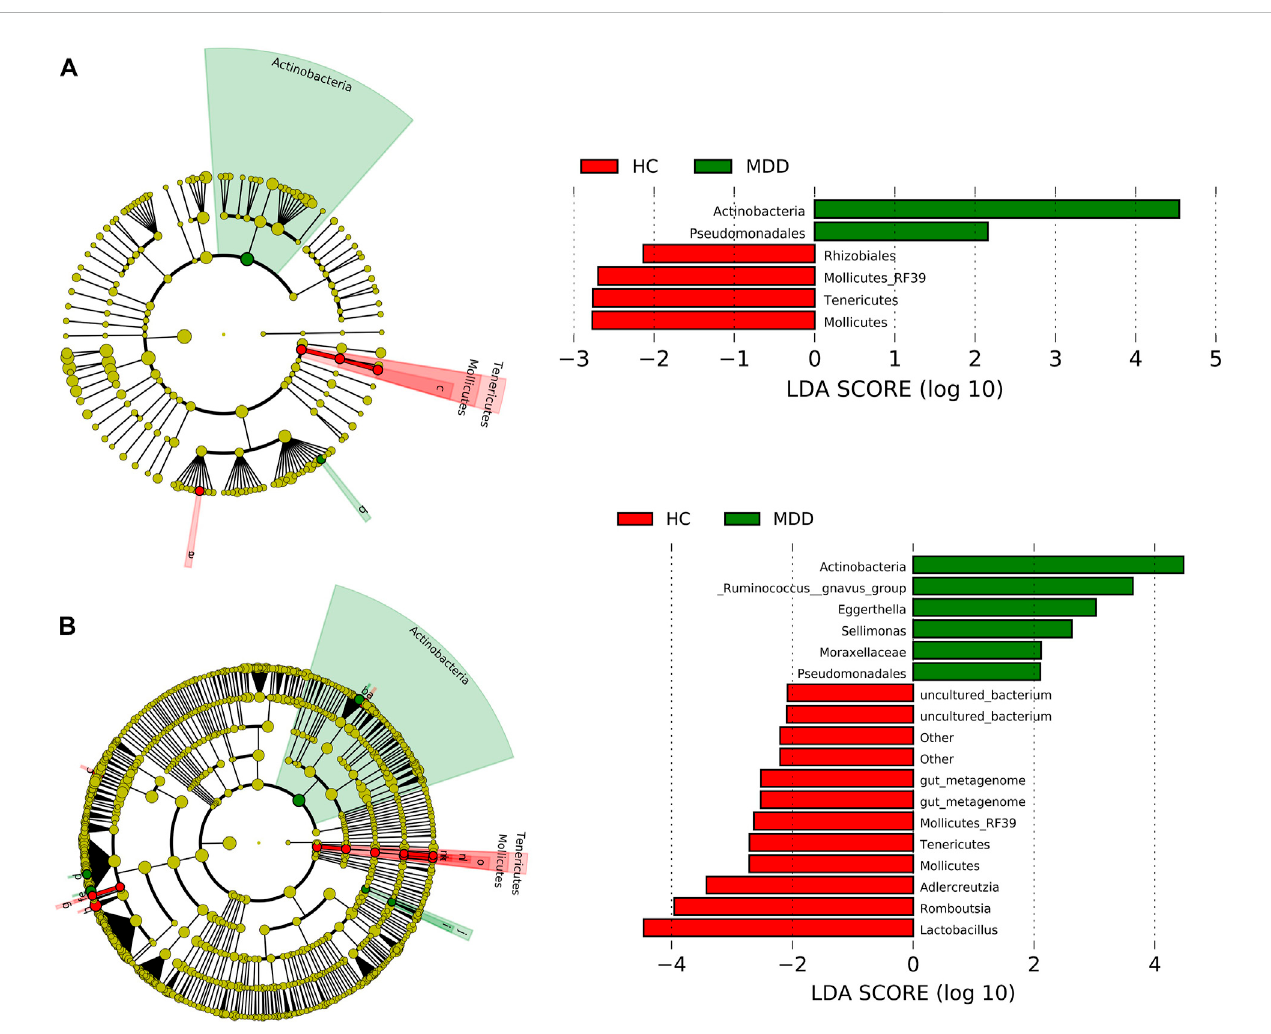
FIGURE 2 Linear discriminant analysis effect size (LEfSe) histograms and the cladograms for the comparisons of major depressive disorder (MDD) versus healthy controls (HCs). (A) LEfSe results at the order level. (B) LEfSe results at the genus level.